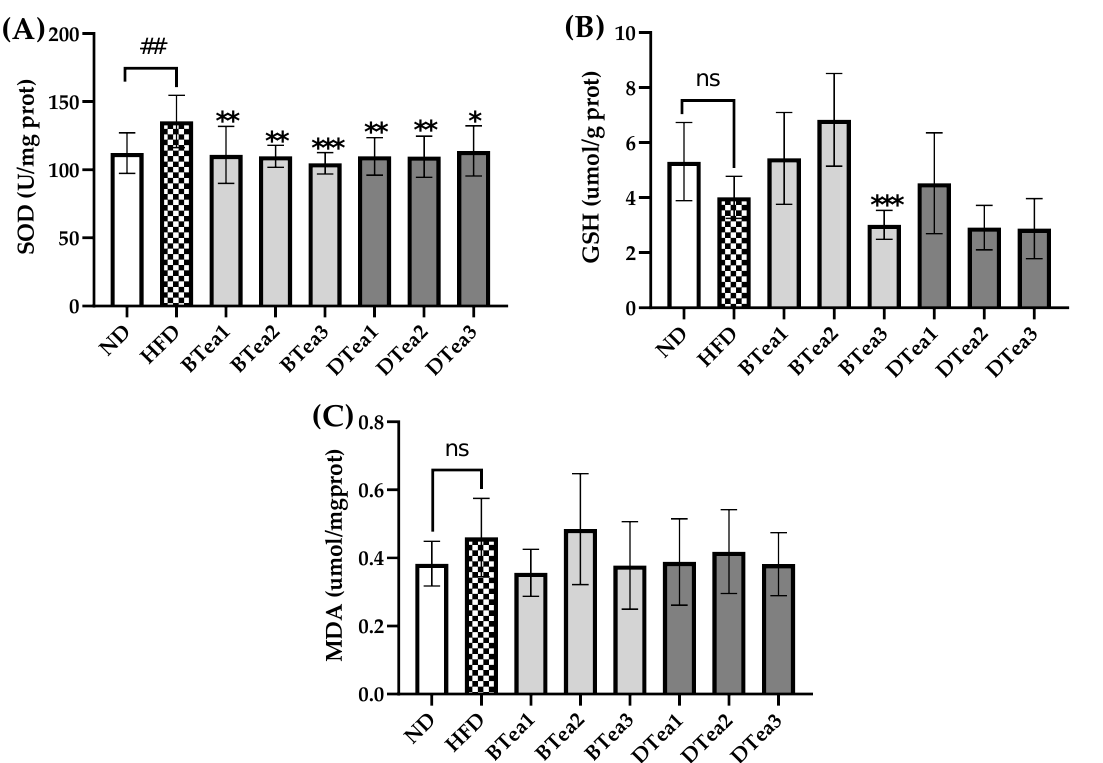
Figure 6. The effects of different black and dark teas on liver oxidative injury. ( A ) superoxide dismutase (SOD); ( B ) glutathione (GSH); ( C ) malondialdehyde (MDA). The results are expressed as mean ± standard deviation. ND, the control group (normal diet group); HFD, the model group (high-fat diet group); BTea1, selenium-enriched black tea; BTea2, Dianhong tea; BTea3, Yingde black tea; DTea1, Fu brick tea; DTea2, Liupao tea; DTea3, selenium-enriched dark tea. ## p < 0.01, the HFD group compared with the ND group; * p < 0.05, ** p < 0.01, *** p < 0.001, the tea extract supplementary groups compared with the HFD group. ns, no statistically significant differences ( p > 0.05) between the model group and the control